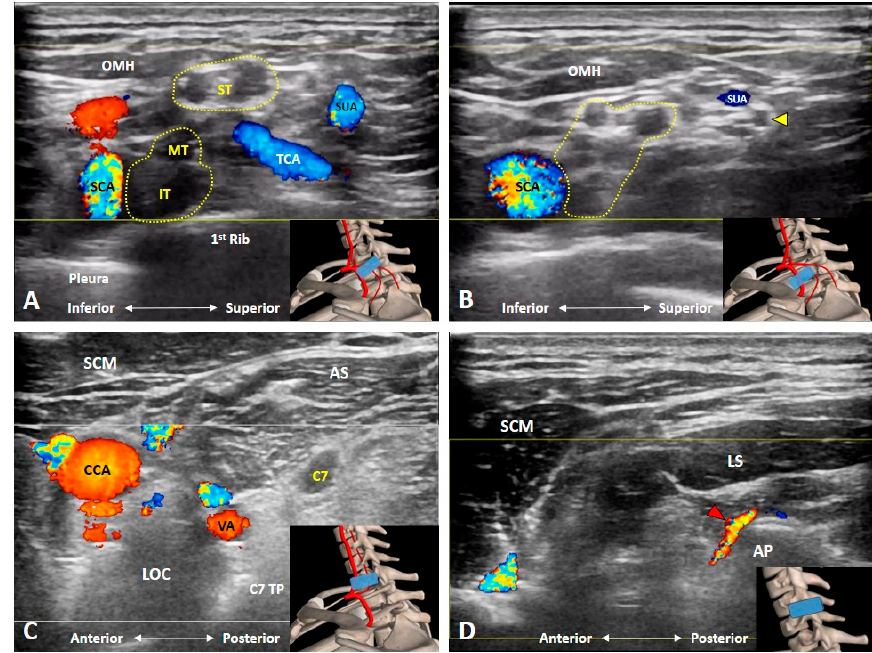
Figure 7. Doppler ultrasound imaging of the transverse cervical artery, thyrocervical trunk ( A ), suprascapular artery and nerve ( B ), vertebral artery ( C ), and radicular artery ( D ). AP: articular pillar; AS: anterior scalene muscle; CCA: common carotid artery; IT: inferior trunk; LOC: longus colli muscle; LS: levator scapulae muscle; MT: middle trunk; OMH: omohyoid muscle; SCA: subclavian artery; SCM: sternocleidomastoid muscle; ST: superior trunk; SUA: suprascapular artery; TCA: transverse cervical artery; VA: vertebral artery. Yellow arrowhead: suprascapular nerve; Red arrowhead: radicular artery. The yellow dashed area encircles the brachial plexus, and the blue rectangles in the bottom-right corners represent the transducer position.